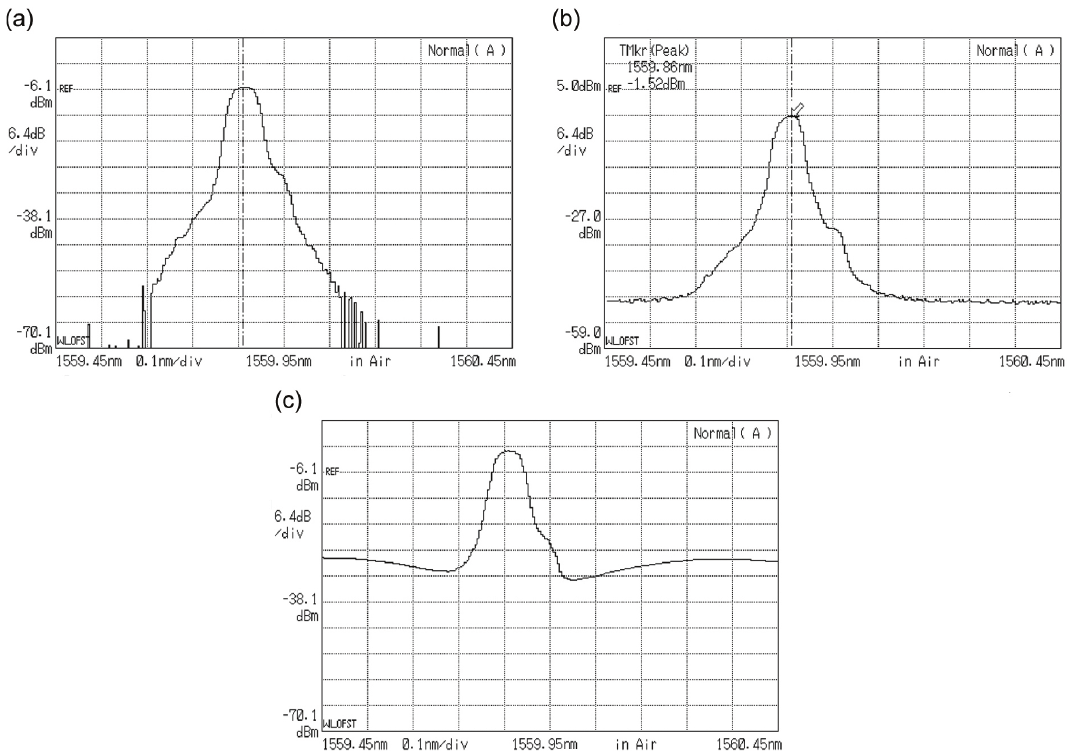
Figure 17. Optical spectrum at 11 Gb/s of ( a ) RSOA input, ( b ) RSOA output and ( c ) BFL output for detuning ∆ λ = − 0.05 nm.